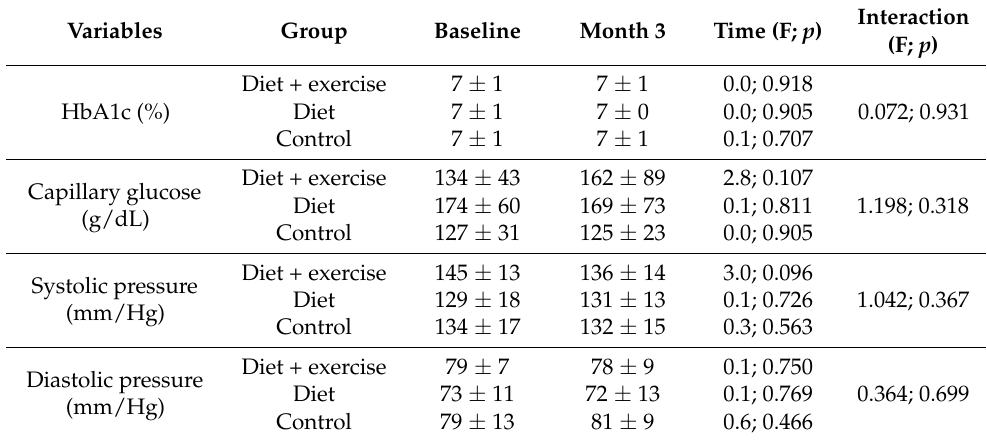
Table 4. Diabetes biomarker and blood pressure per assessment, per group.